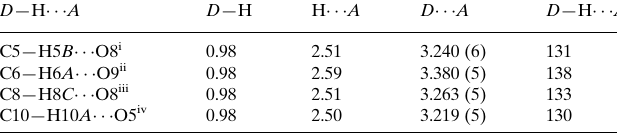
Hydrogen-bond geometry (A˚ , (cid:2)